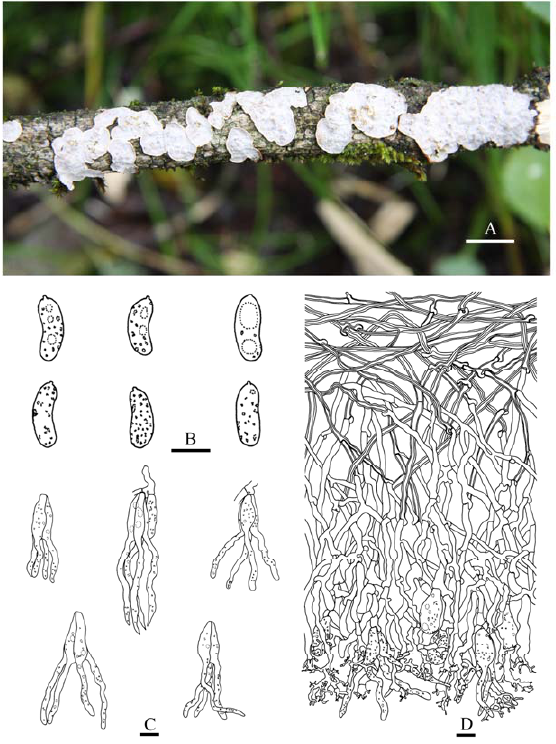
Figure 9. Eichleriella alpina (from the holotype, He 20120916-1, BJFC 014581). Scale bars: ( A ) = 1 cm; ( B – D ) = 10 μ m. ( A ). Basidiomes; ( B ). Basidiospores; ( C ). Basidia; ( D ). A cross section of the basidiome.